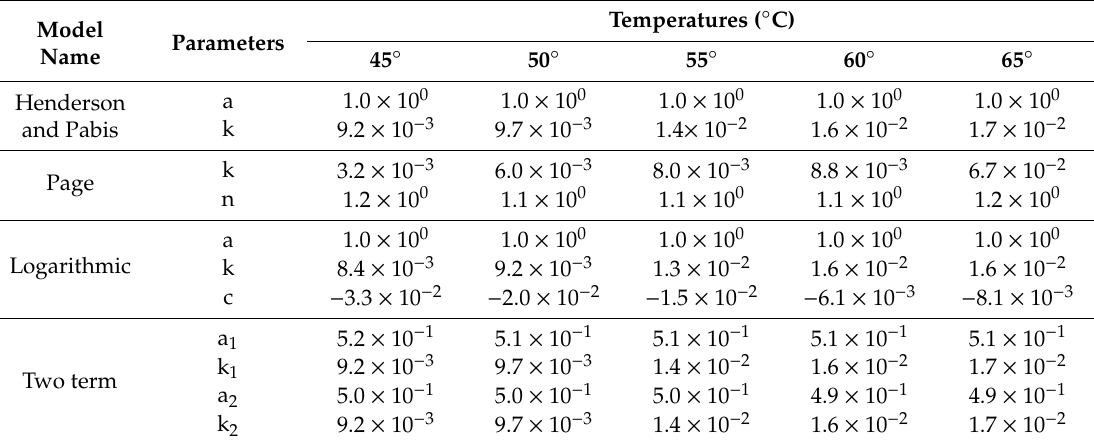
Table 4. Model parameters (k, k 1 and k 2 , the drying constants; a, a 1 , a 2 , c, n, the drying coe ffi cients) of the drying